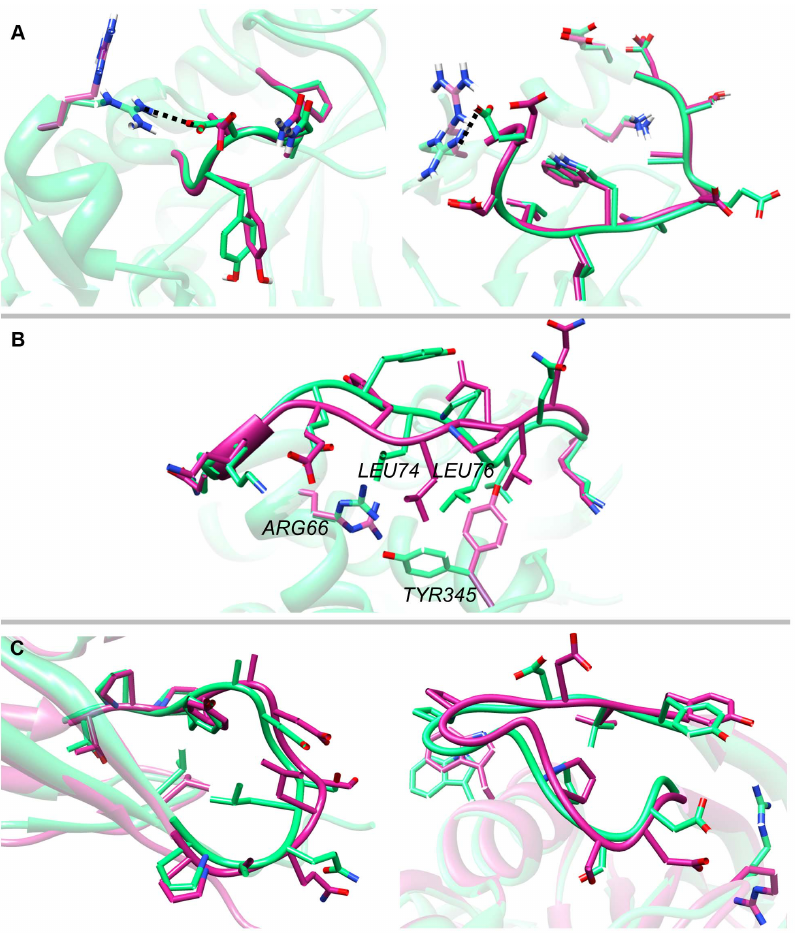
Figure 2. Examples of loops modeled in inaccurate environmental structures. In all panels, the crystal structures are colored in green and the models in magenta. Framework structures are shown transparent for clarity. (A) Two examples of tolerating errors in surrounding side chains, 1oyc (left; RMSD 5 0.4 A˚ ) and 1c5e (right; RMSD 5 0.5 A˚ ). The loop-framework salt bridges in the crystal structures are indicated with black dotted lines. High-accuracy modeling is possible even though the salt bridges cannot be recovered owing to the perturbed arginine orientations in the framework. (B) An example of unsuccessful modeling in the framework of perturbed side-chains, 1oth (RMSD 5 2.3 A˚ ), showing the necessity of additional sampling. The perturbed Arg66 and Tyr345 side chains (magenta) would clash with the two leucine residues in the loop if the crystal loop structure were to be placed. (C) Two examples of tolerating additional backbone errors, 1my7 (left; RMSD 5 1.0 A˚ ) and 1cb0 (right; RMSD 5 0.9 A˚ ). The overall backbone trace and key side-chain interactions are well